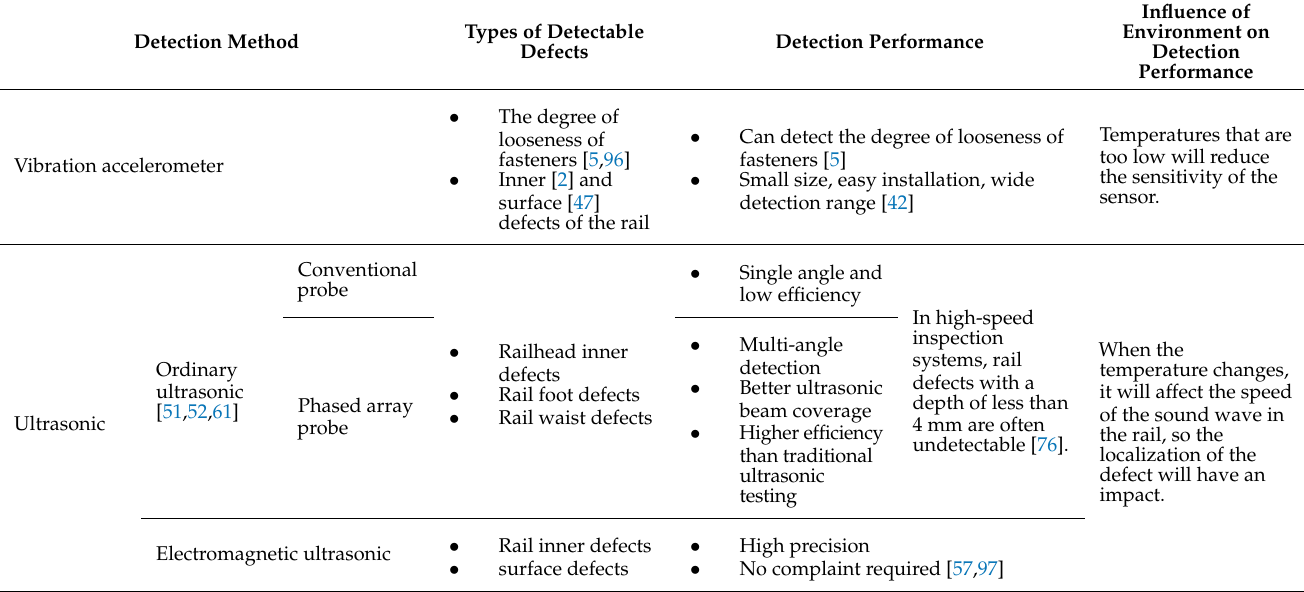
Table 7. Comparison of rail defect detection